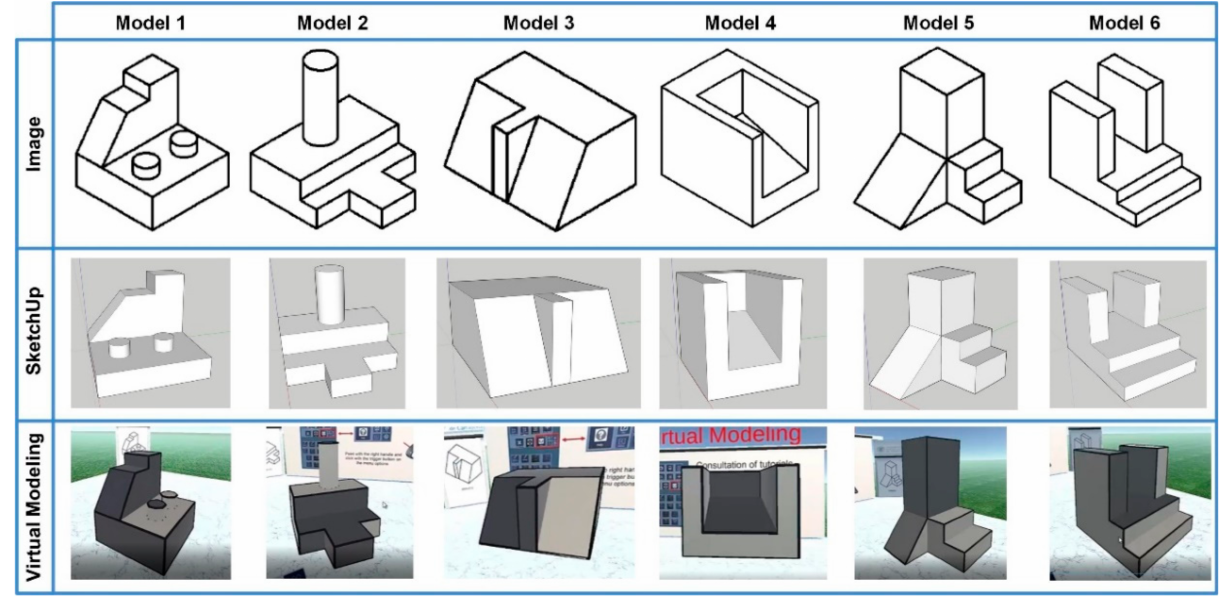
Figure 7. Set of models used in our